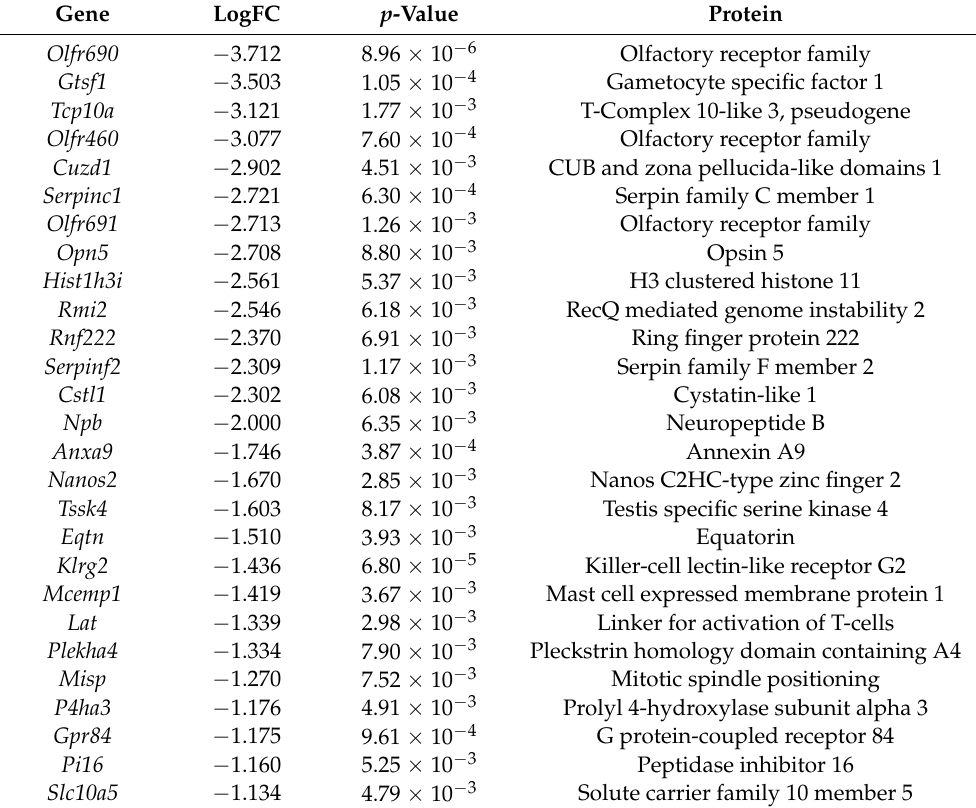
Table 2. Differentially expressed genes downregulated by